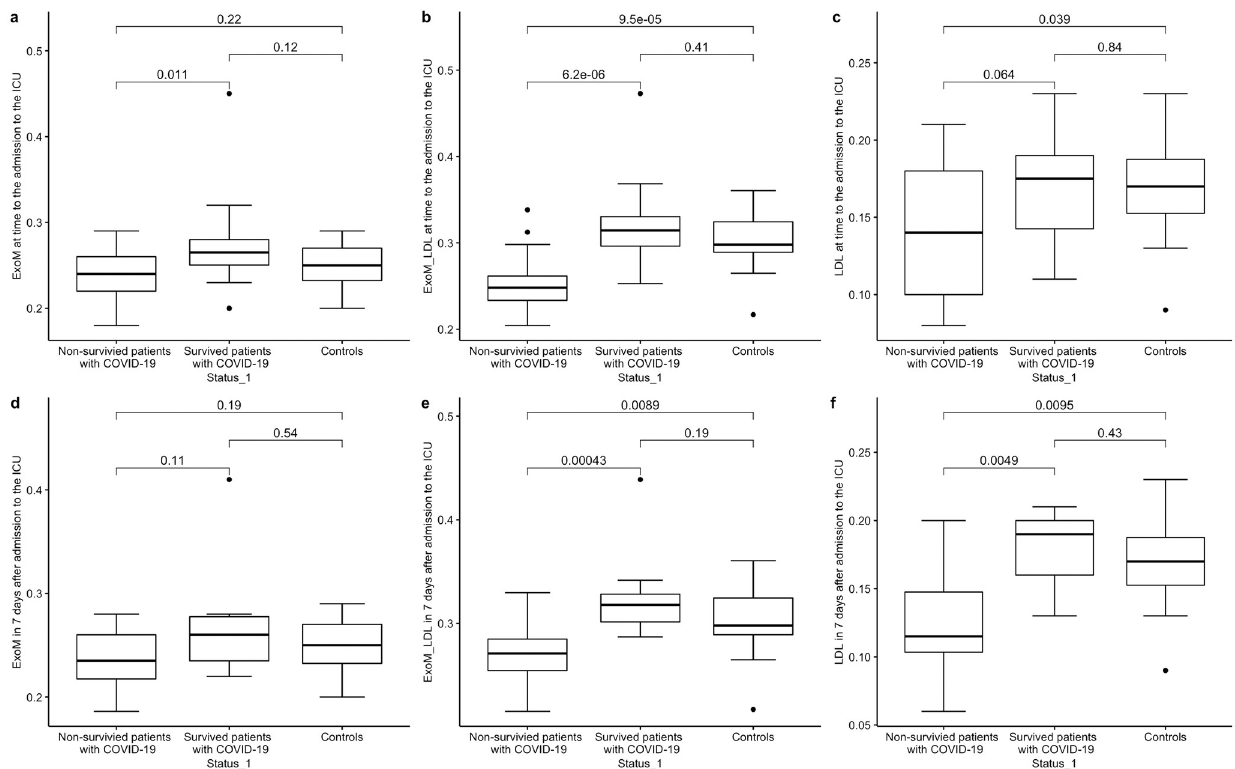
Fig 1. Relative level of plasma exomeres in patients with the Delta variant and controls with concentration of TC bound by LDL: a. ExoM (admission to the ICU), b. ExoM_LDL (admission to the ICU), c. LDL (admission to the ICU), d. ExoM (7 days after admission to the ICU), e. ExoM_LDL (7 days after admission to the ICU), f. LDL (7 days after admission to the